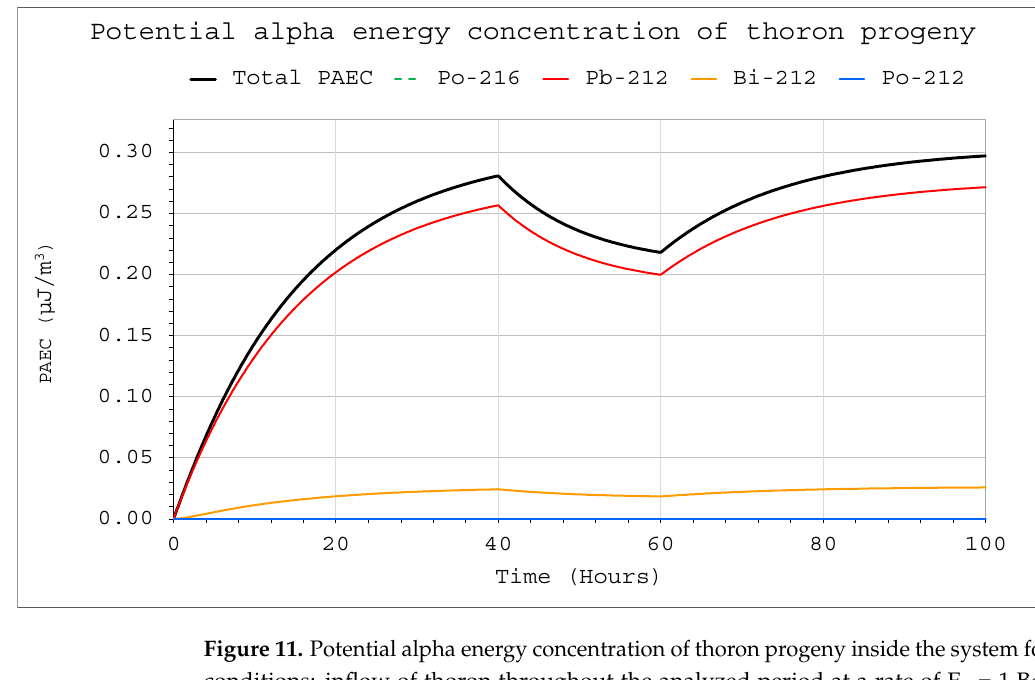
Figure 10. Activity concentration of thoron and its progeny inside the system for the following con- ditions: inflow of thoron throughout the analyzed period at a rate of E 1 = 1 Bq/s, V = 1 m 3 , C oi = 0. The filtration system was operating in the range of 40–60 h with a flow rate of Q D = 10 L/min and a filtration efficiency of F = 100%.